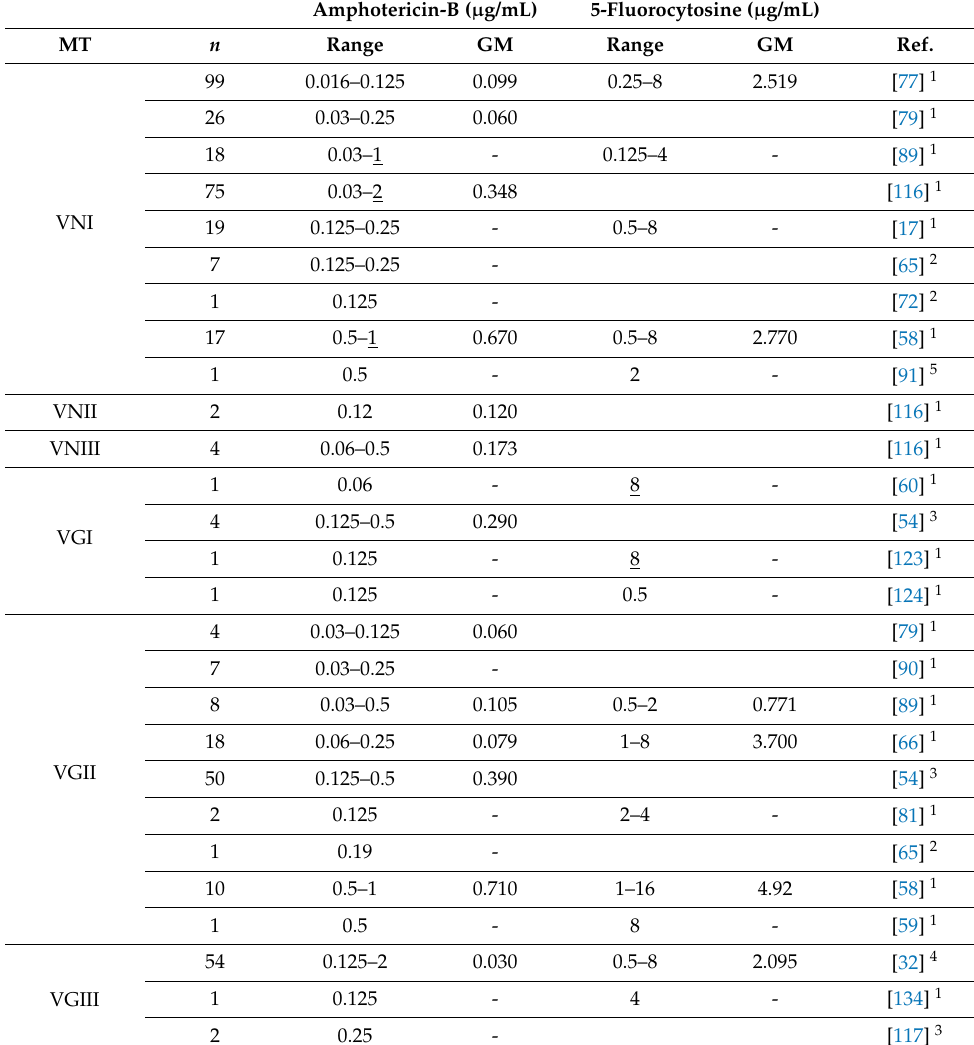
Table 3. Minimum inhibitory concentrations of amphotericin-B and 5-fluorocytosine for Cryptococcus neoformans and Cryptococcus gattii species complexes isolates from Latin America, ac- cording to the molecular type. Non-wild-type minimum inhibitory concentrations are underlined. Amphotericin-B ( µ g/mL)